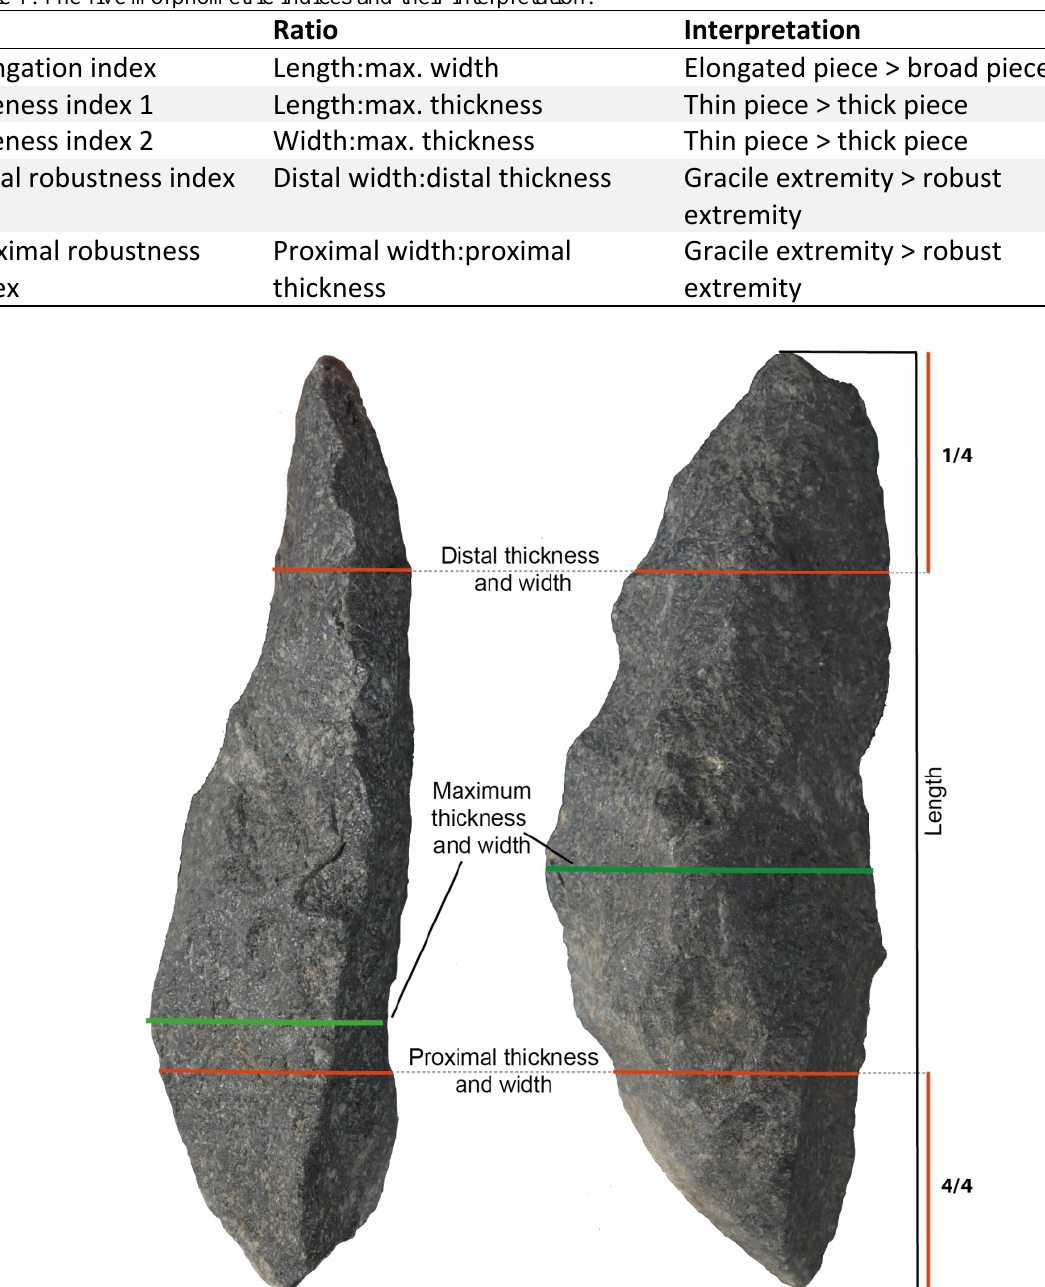
Table 1. The five morphometric indices and their interpretation.